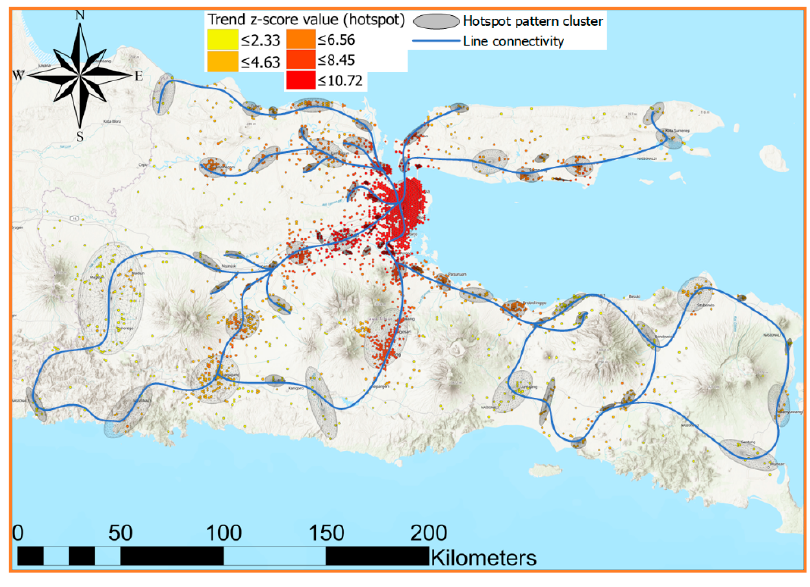
Figure 9. Amoeba-shaped hotspot connectivity pattern in East Java Province.